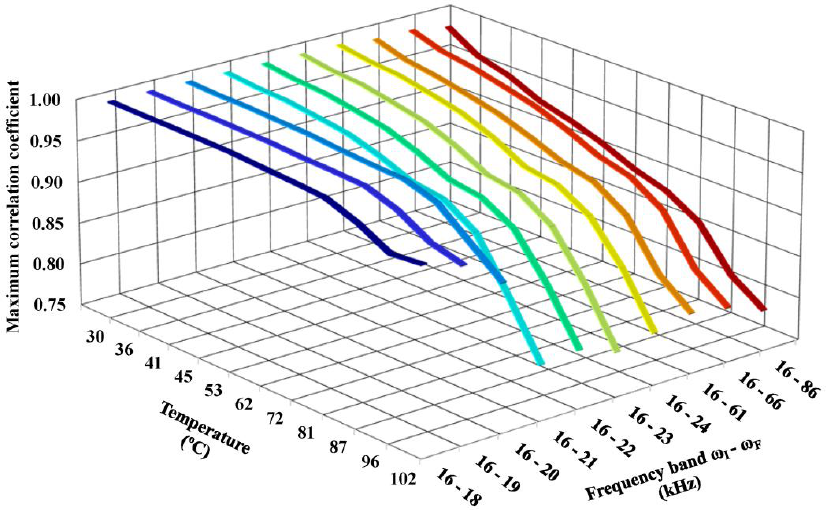
Figure 17. Maximum correlation coefficients obtained using the compensation